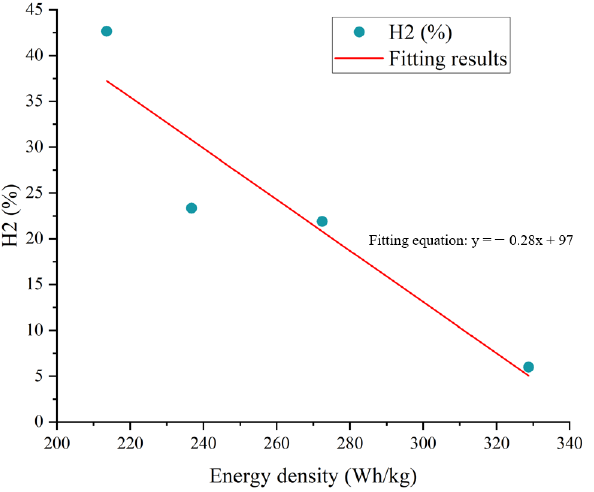
Figure 8. Relationship between H 2 concentration and battery energy density.